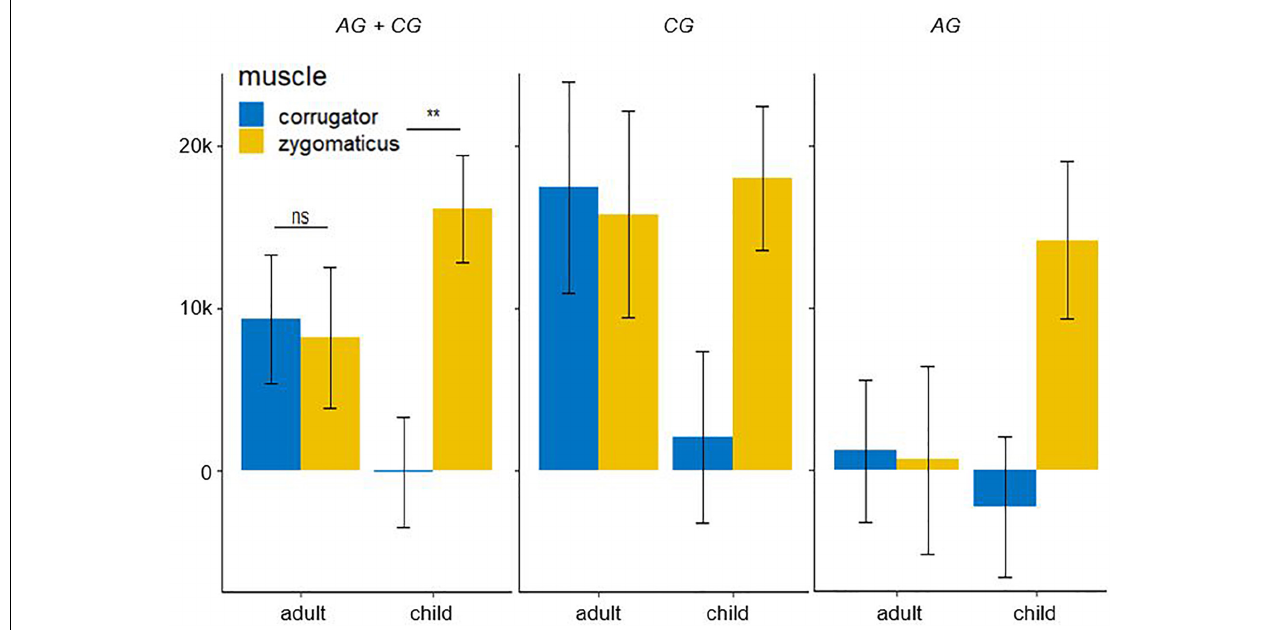
FIGURE 7 | Electromyographic activity ( µ V × ms) over entire measurement interval (0–4000 ms) for the interaction effect consisting of the within-subject factors age (children and adult faces) and muscle (corrugator and zygomaticus) for both group. A significant lower EMG-activity was found for the corrugator in response to faces children. Negative EMG activity is caused by the baseline correction; error-bars represent the standard error. The symbol ** indicates p < 0.01. ns indicates not